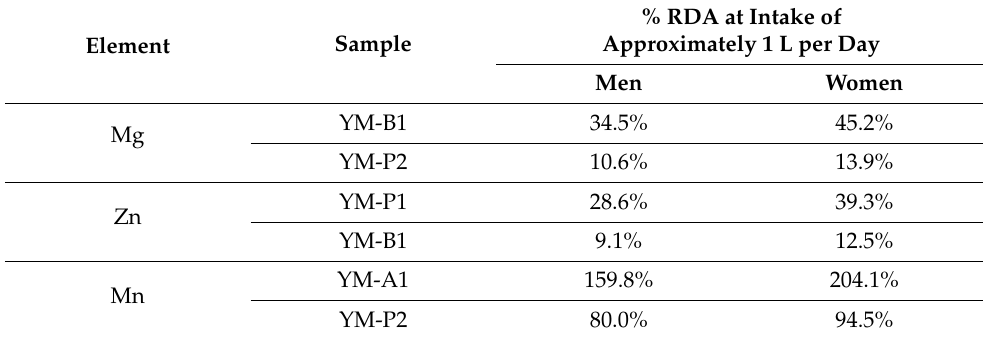
Table 2. Coverage of the daily recommended requirement when drinking 1 L of yerba mate infusion per day prepared using the described